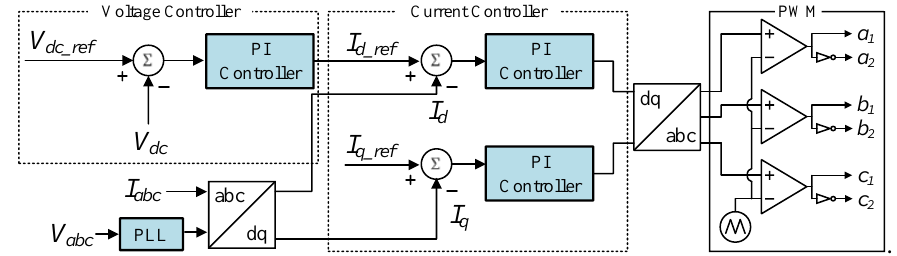
Figure 5. Control block diagram.